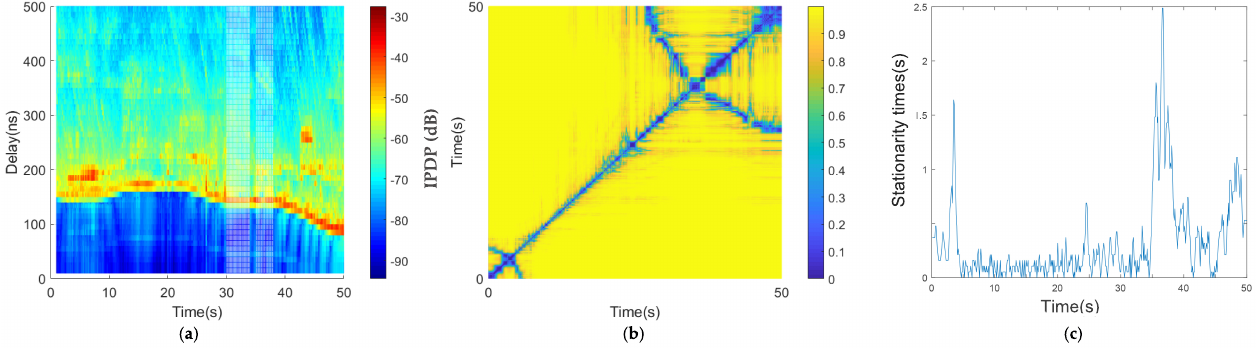
Figure 9. Results of the car-following, high-speed scenario on the viaduct: ( a ) average PDPs, ( b ) temporal PDP correlation coefficient, and ( c ) stationarity time